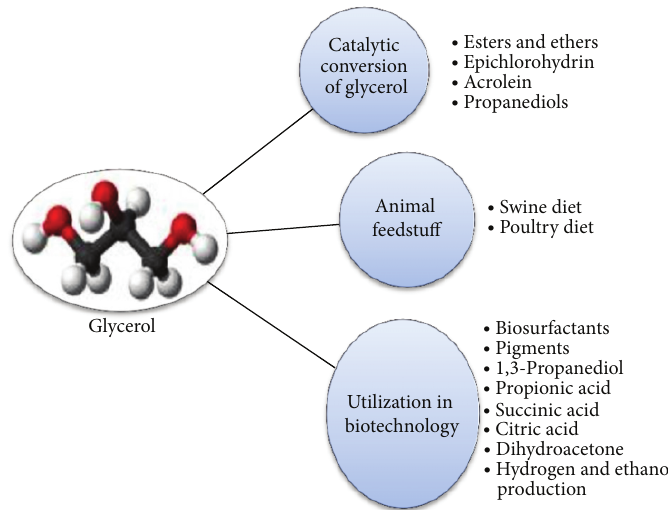
Figure 1: Value-added chemicals obtainable from glycerol.